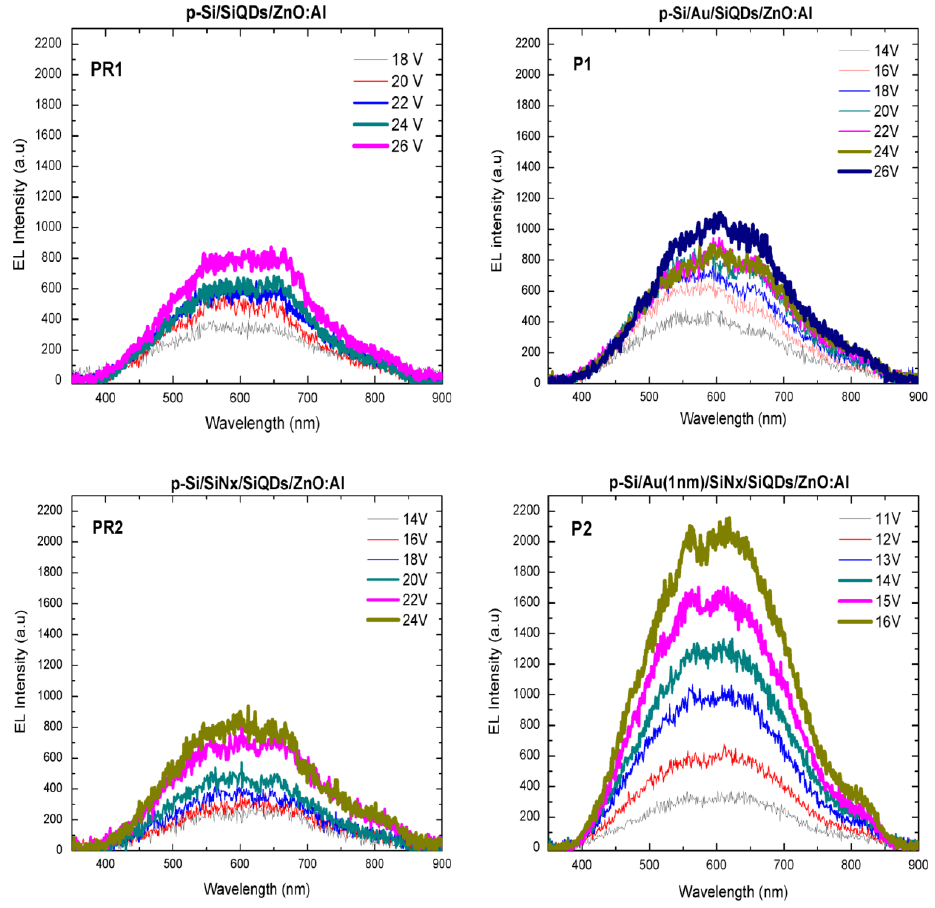
Figure 5. Electroluminescent (EL) spectra of the PR1 (p-Si/SiQDs/ZnO-Al), P1 (p- Si/AuNPs/SiQDs/ZnO-Al), PR2 (p-Si/SiN x /SiQDs/ZnO-Al) and P2 (p-Si/AuNPs/SiNx/SiQDs/ZnO-Al) samples under forward bias. SiQDs/ZnO-Al), PR2 (p-Si/SiN x /SiQDs/ZnO-Al) and P2 (p-Si/AuNPs/SiN x